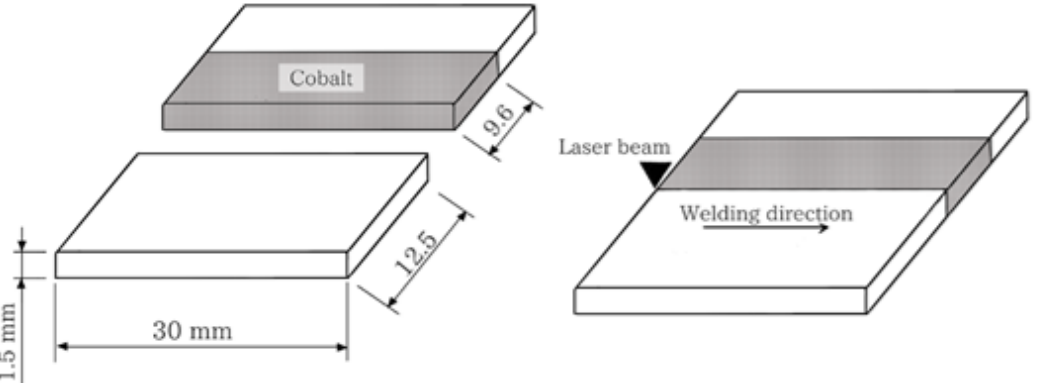
Figure 1. Samples dimensions and schematic representation of the butt weld joint configuration.